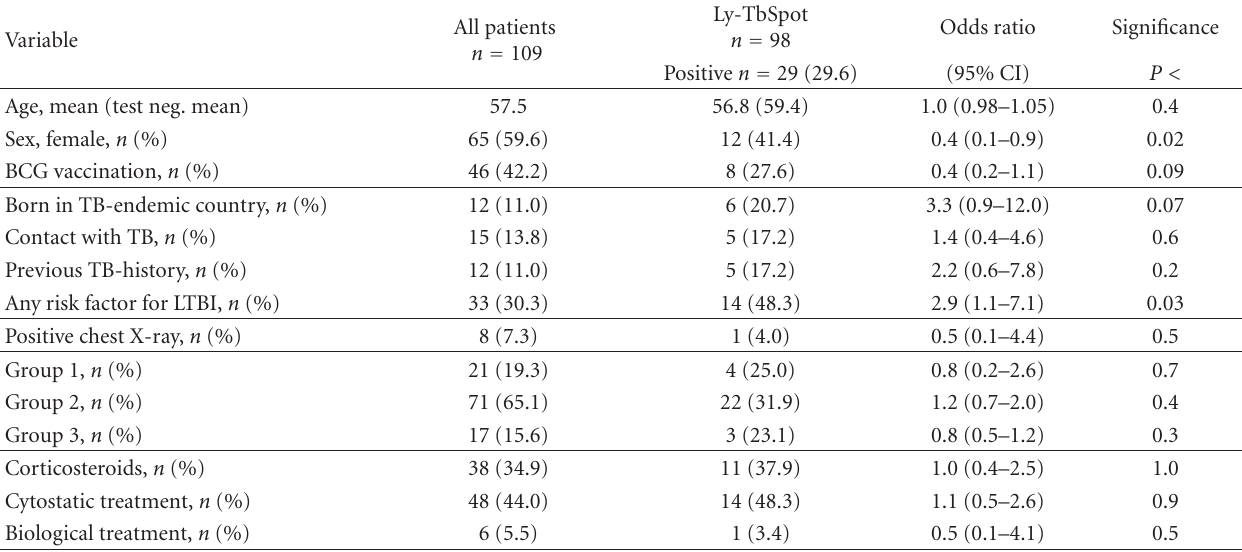
Table 3: The univariate analysis of the TB risk factors with a positive outcome of the Ly-TbSpot test.